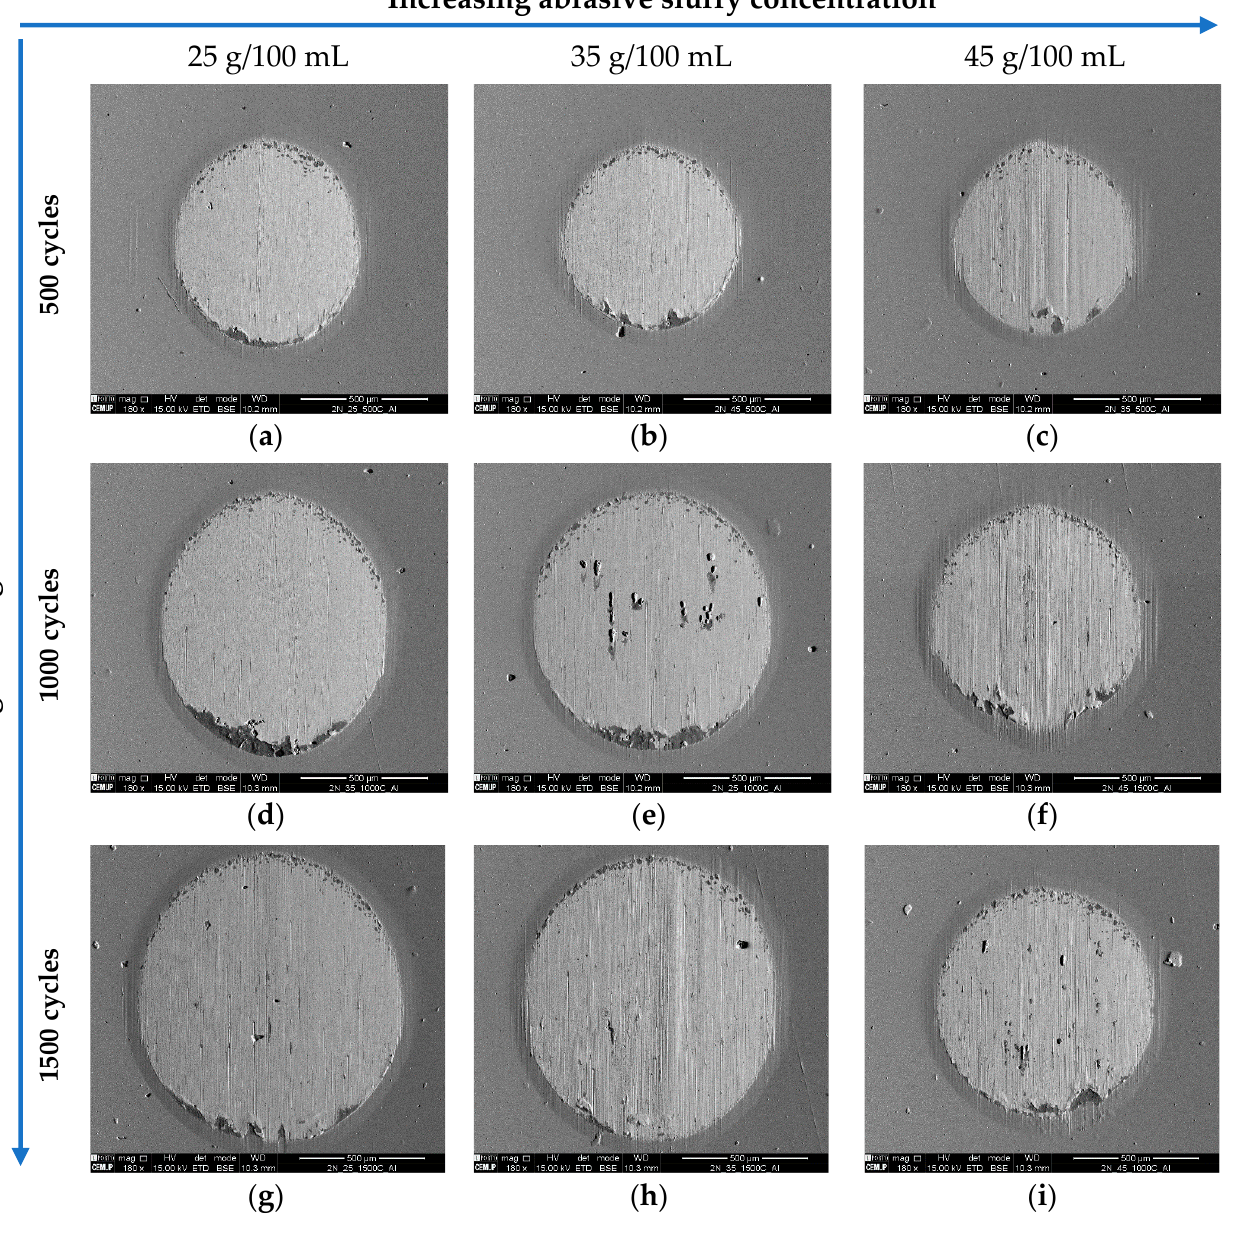
Figure 10. Wear craters generated by the test ball AISI 52100 and Alumina abrasive particles with a 2 N normal load. ( a ) SC 25 g/100 mL and 500 cycles; ( b ) SC 35 g/100 mL and 500 cycles; ( c ) SC 45 g/100 mL and 500 cycles; ( d ) SC 25 g/100 mL and 1000 cycles; ( e ) SC 35 g/100 mL and 1000 cycles; ( f ) SC 45 g/100 mL and 1000 cycles; ( g ) SC 25 g/100 mL and 1500 cycles; ( h ) SC 35 g/100 mL and 1500 cycles; ( i ) SC 45 g/100 mL and 1500 cycles.